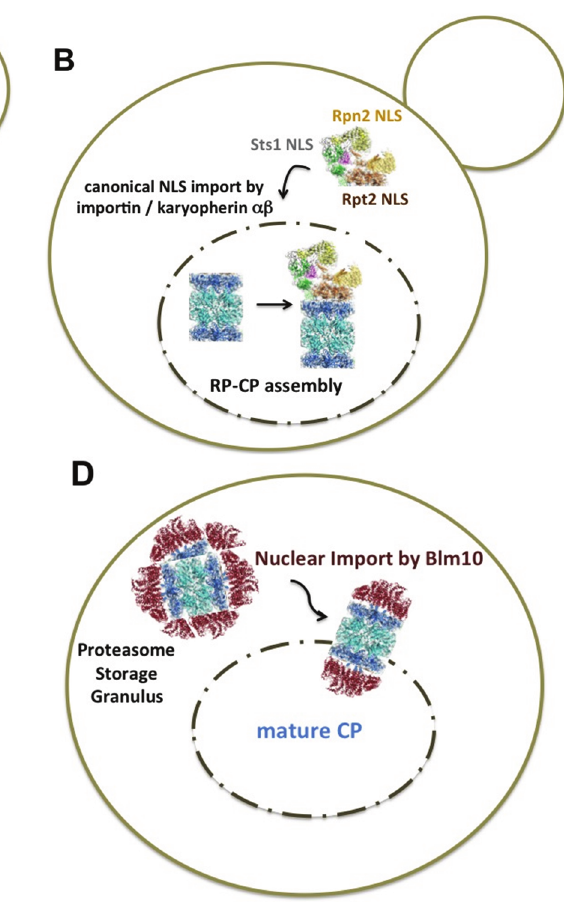
Figure 1. Current models of the nuclear import of yeast proteasomes ( A ) In highly proliferating cells, nuclear proteasomes are assembled from proteasomal modules that are recognized by the canonical import receptor, importin/karyopherin (cid:2)(cid:3). Classical nuclear localization sequences (NLS) are accessible in (cid:2) subunits of CP precursor complexes with disordered (cid:2) rings [39–41]. The dimerization of two half-CP yields the pre-holo-CP, a labile CP precursor complex. In the pre-holo-CP, the active sites are freed by (cid:3)-propeptide processing, which is guided by the CP-dedicated maturation factor Ump1. Ump1 is degraded upon CP maturation. The (cid:2) rings are closed, and the NLS is no longer accessible [17,35]. ( B ) The RP is imported into the nucleus by the canonical NLS receptor pathway. Rpt2 and Rpn2 confer NLS to the RP base and Sts1 to the RP lid. Sts1 is a short-lived protein and degraded by RP-CP assemblies [34,36,38]. ( C ) Proteasomes are imported into the nucleus as holo-enzymes independent of the canonical importin/karyopherin (cid:2)(cid:3) pathway. The regulation of this recently discovered import pathway is not yet understood [47]. ( D ) When quiescent cells resume growth, nuclear import of mature CP is facilitated by Blm10, a conserved 240-kDa HEAT-like repeat protein with structural similarity to karyopherin (cid:3) [48]. Blm10 preferentially binds to CP with disordered (cid:2) rings, which is comparable with (cid:2) ring conformations in the pre-holo-CP and half-CP. Open or disordered (cid:2) rings represent an import-competent conformation [49]. CP precursor complexes are not available during quiescence, due to stalled protein synthesis. Proteasome structures were drawn according to cryo-electron microscopy studies with a license from Cell Press Elsevier